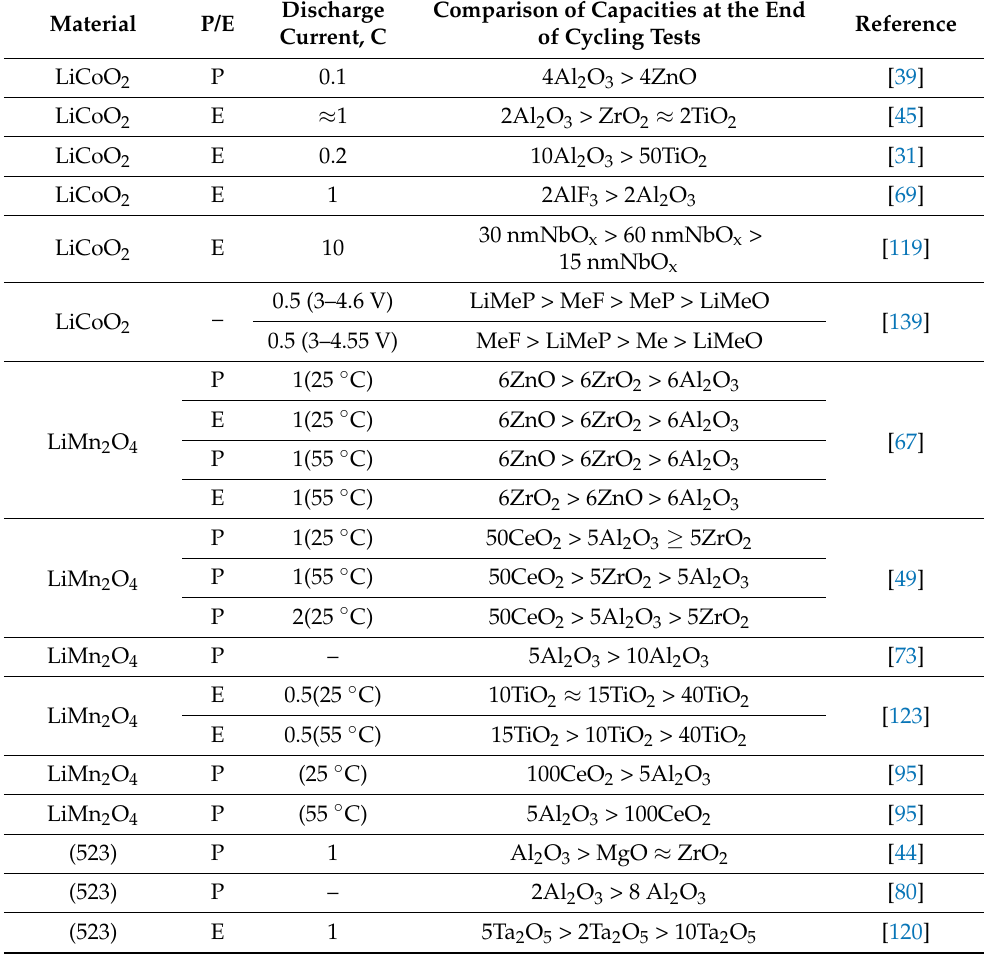
Table 7. Effect of coating selection on capacity retention of active cathode materials during cyclic